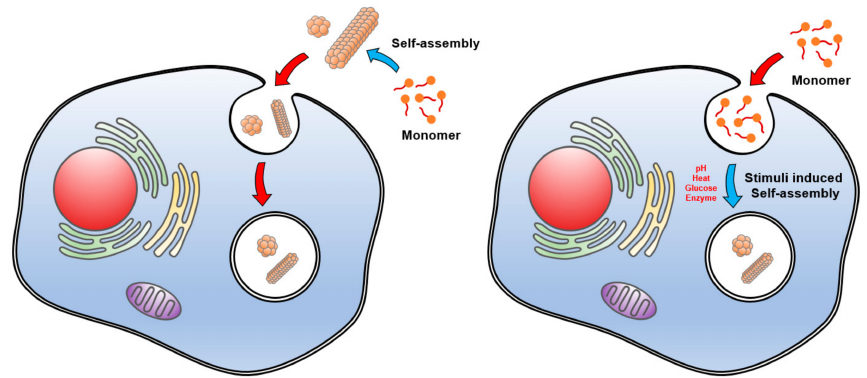
Figure 3. Concept of conventional forward (left) and novel reverse (right) self-assembly of peptides. Cellular environment and extrinsic stimuli such as endogenous changes of pH, glucose, enzyme activity, and heat drive in-cell self-assembly of peptides in the target